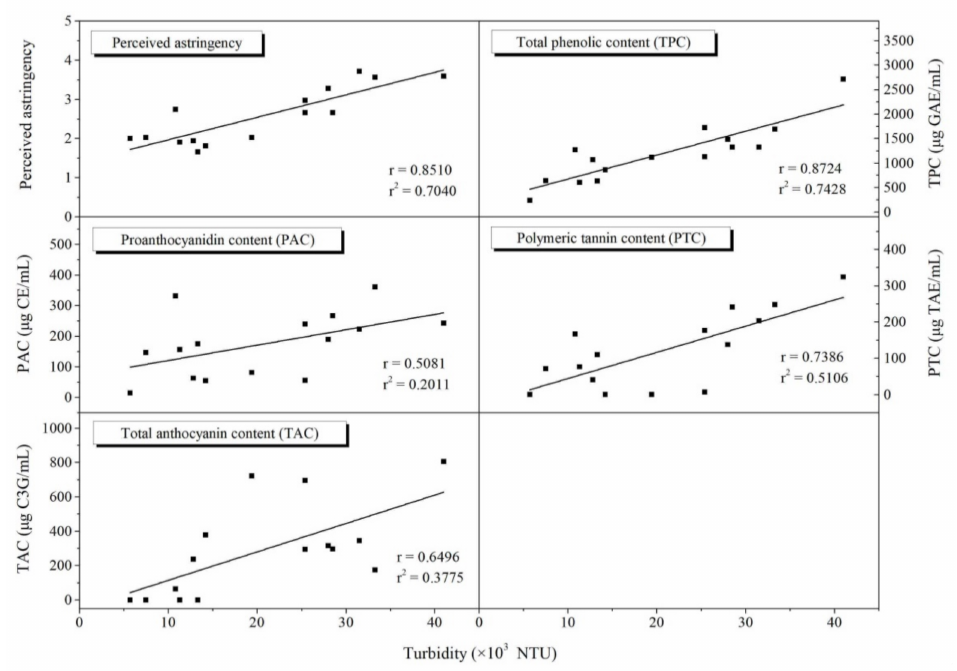
Figure 4. Plots of the correlations between turbidity and perceived astringency, the TPC, the PAC, the PTC and the